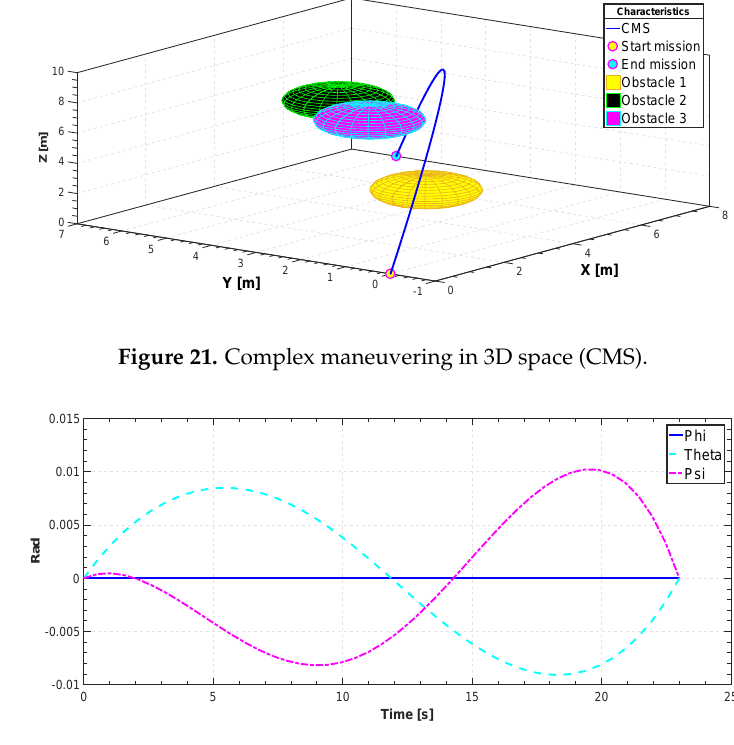
Figure 22. Roll, pitch and yaw angle for CMS.